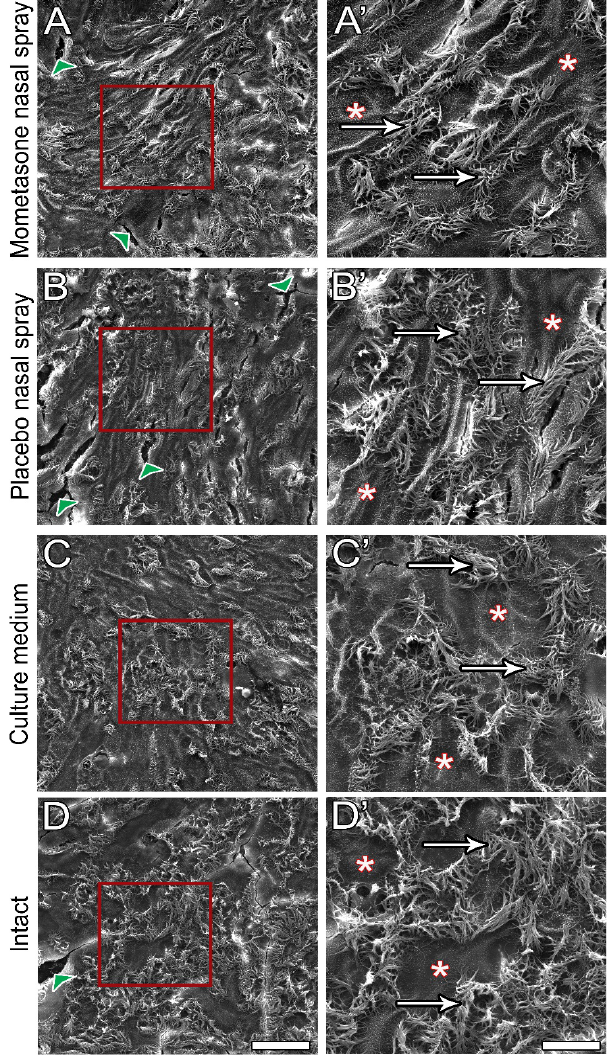
Figure 7. Post-treatment ultrastructural SEM analysis of the apical surface topography of the nasal MucilAir TM in vitro models. Cultures were treated with 10-fold diluted mometasone nasal spray ( A , A’ ), 10-fold diluted placebo nasal spray ( B , B’ ), or culture medium ( C , C’ ) for 14 consecutive days. Intact cultures were not treated ( D , D’ ). Ciliated cells (arrows) and non-ciliated cells (asterisks) with apparent cell boundaries are observed in all cultures, regardless of the treatment. Arrowheads indicate artefacts. The red framed areas in images A – D are magnified in A’ – D’ . Scale bars, 50 µm ( A – D ) and 25 µm ( A’ – D’ ).